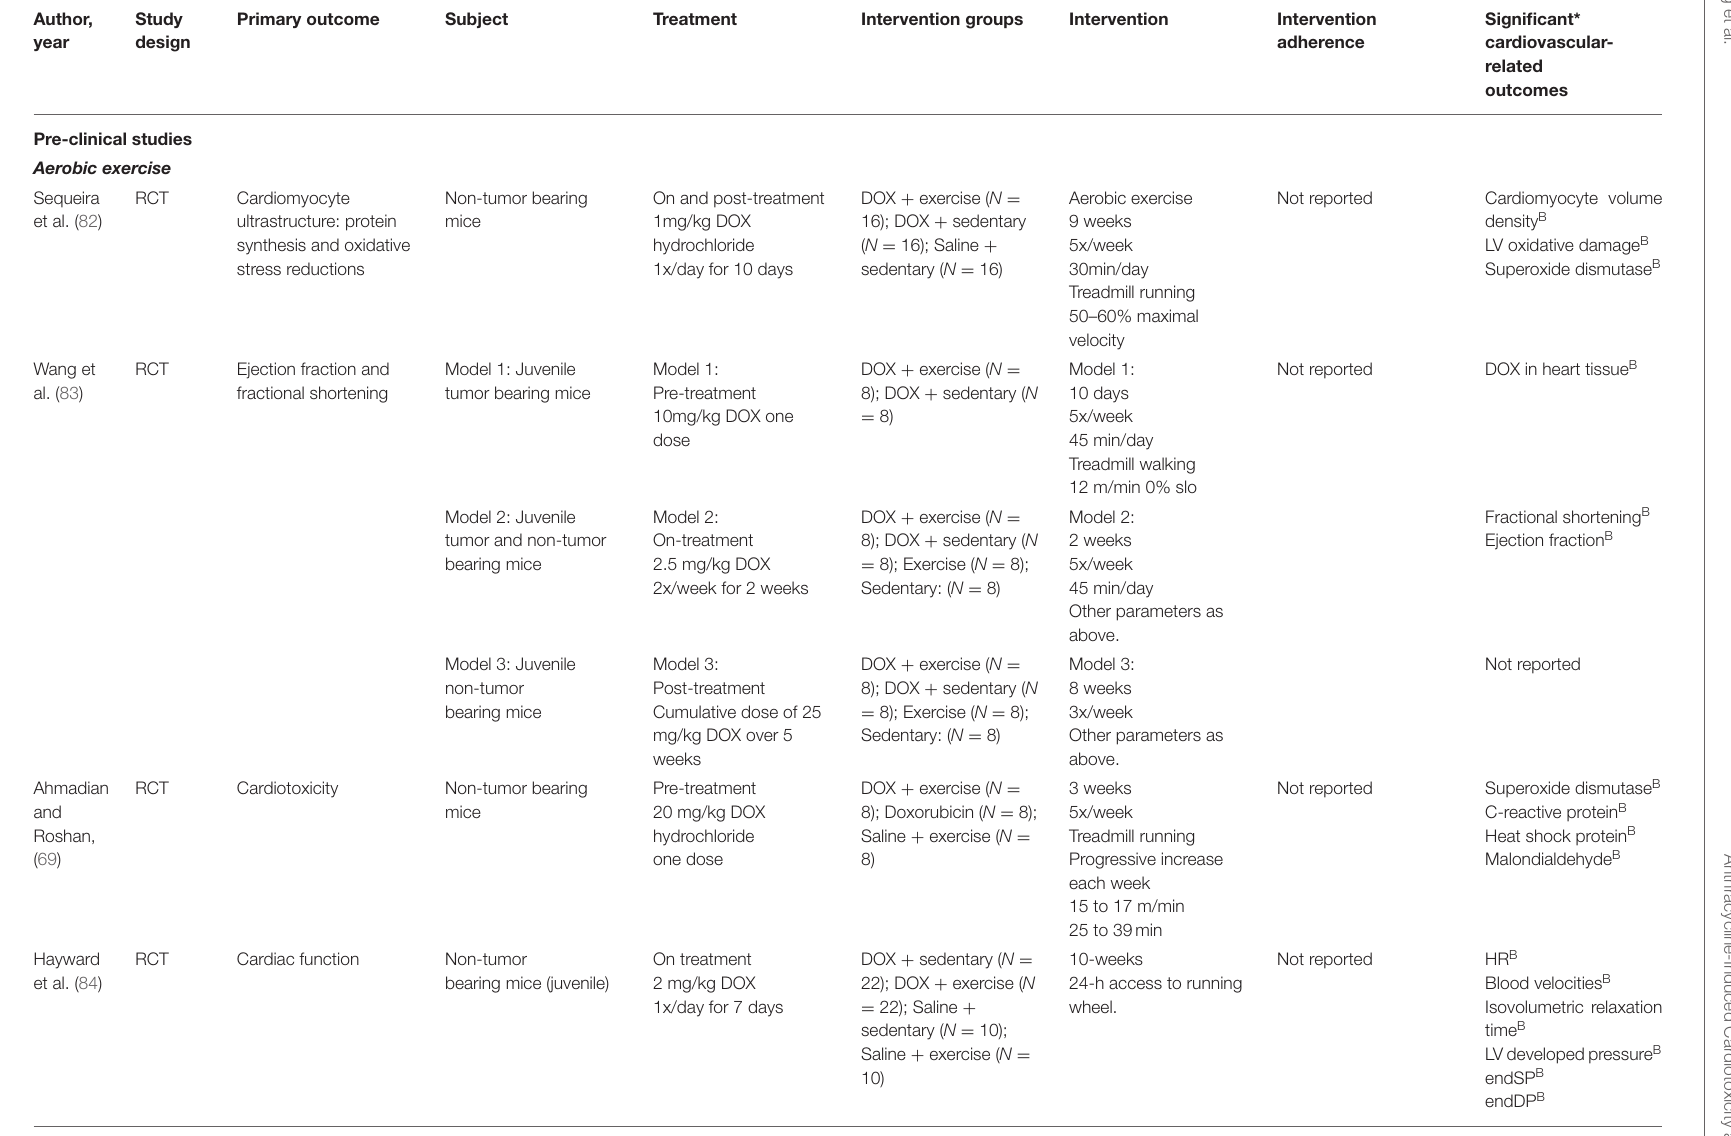
TABLE 2 | Summary of exercise cardio-oncology